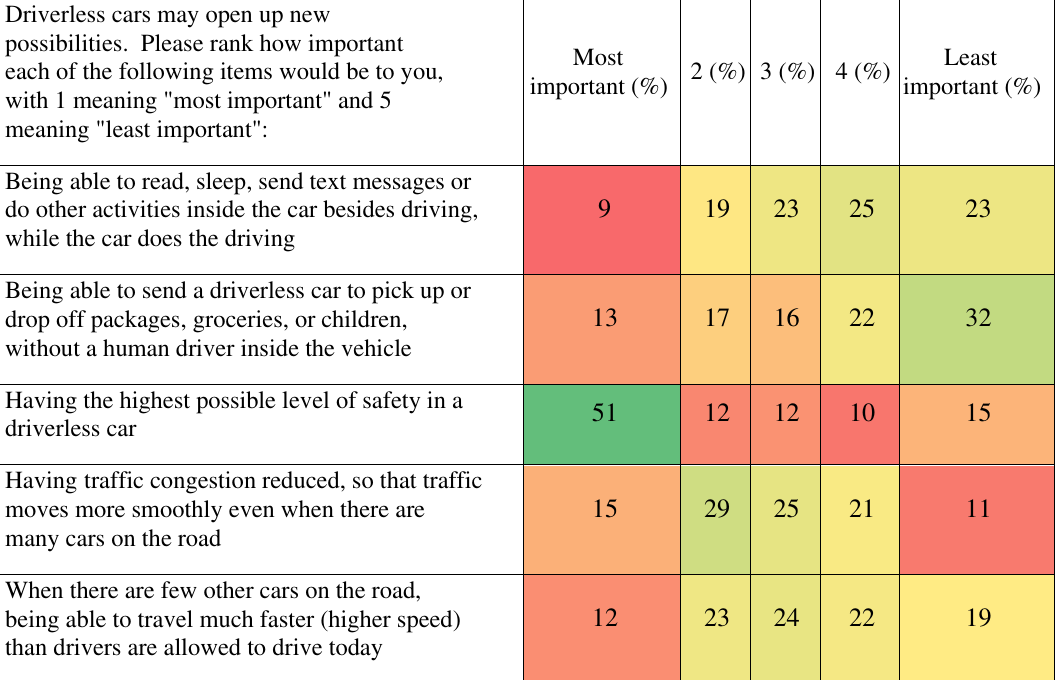
Table 3 Preferences for automated cars’ programming instructions Driverless cars may open up new possibilities. Please rank how